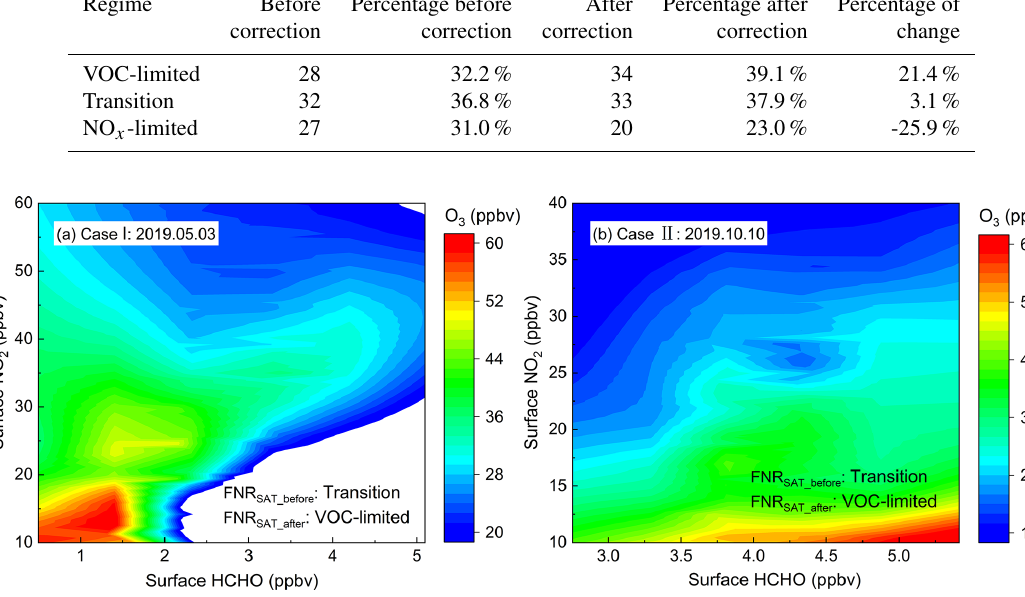
rection were compared with those of surface